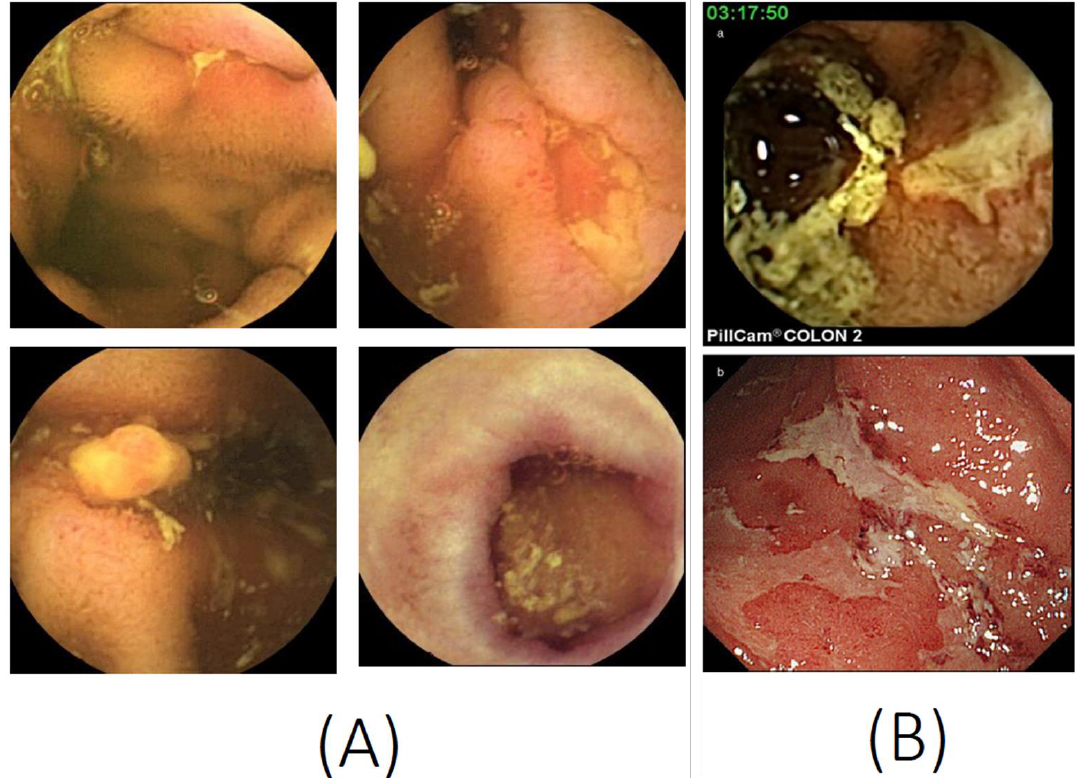
Figure 1. Capsule endoscopy images. ( A ) Small bowel capsule endoscopy features of Crohn’s disease, such as ulcers, longitudinal ulcers, inflammatory polyps, and scars. ( B ) A colon capsule endoscopy image ( a ) consistent with the conventional colonoscopy image ( b ) of ulcerative colitis (photocopies from Hosoe N, et al. J. Gastroenterol. Hepatol. 2013, 28, 1174–1179, with permission from John Wiley and Sons [17]).